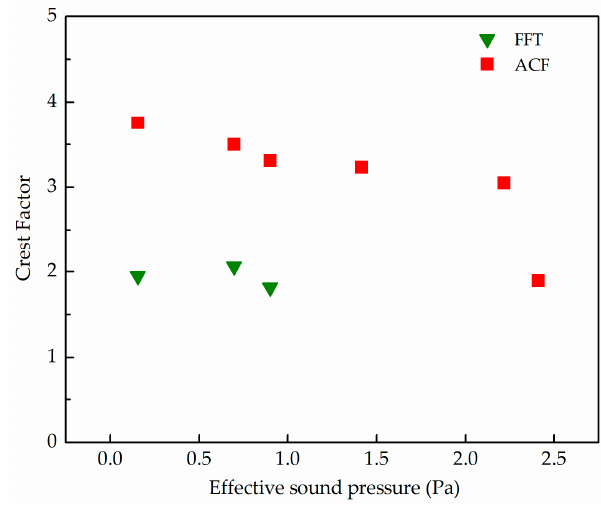
Figure 15. Comparison of Crest Factor of the signal between FFT and ACF under different noise levels.